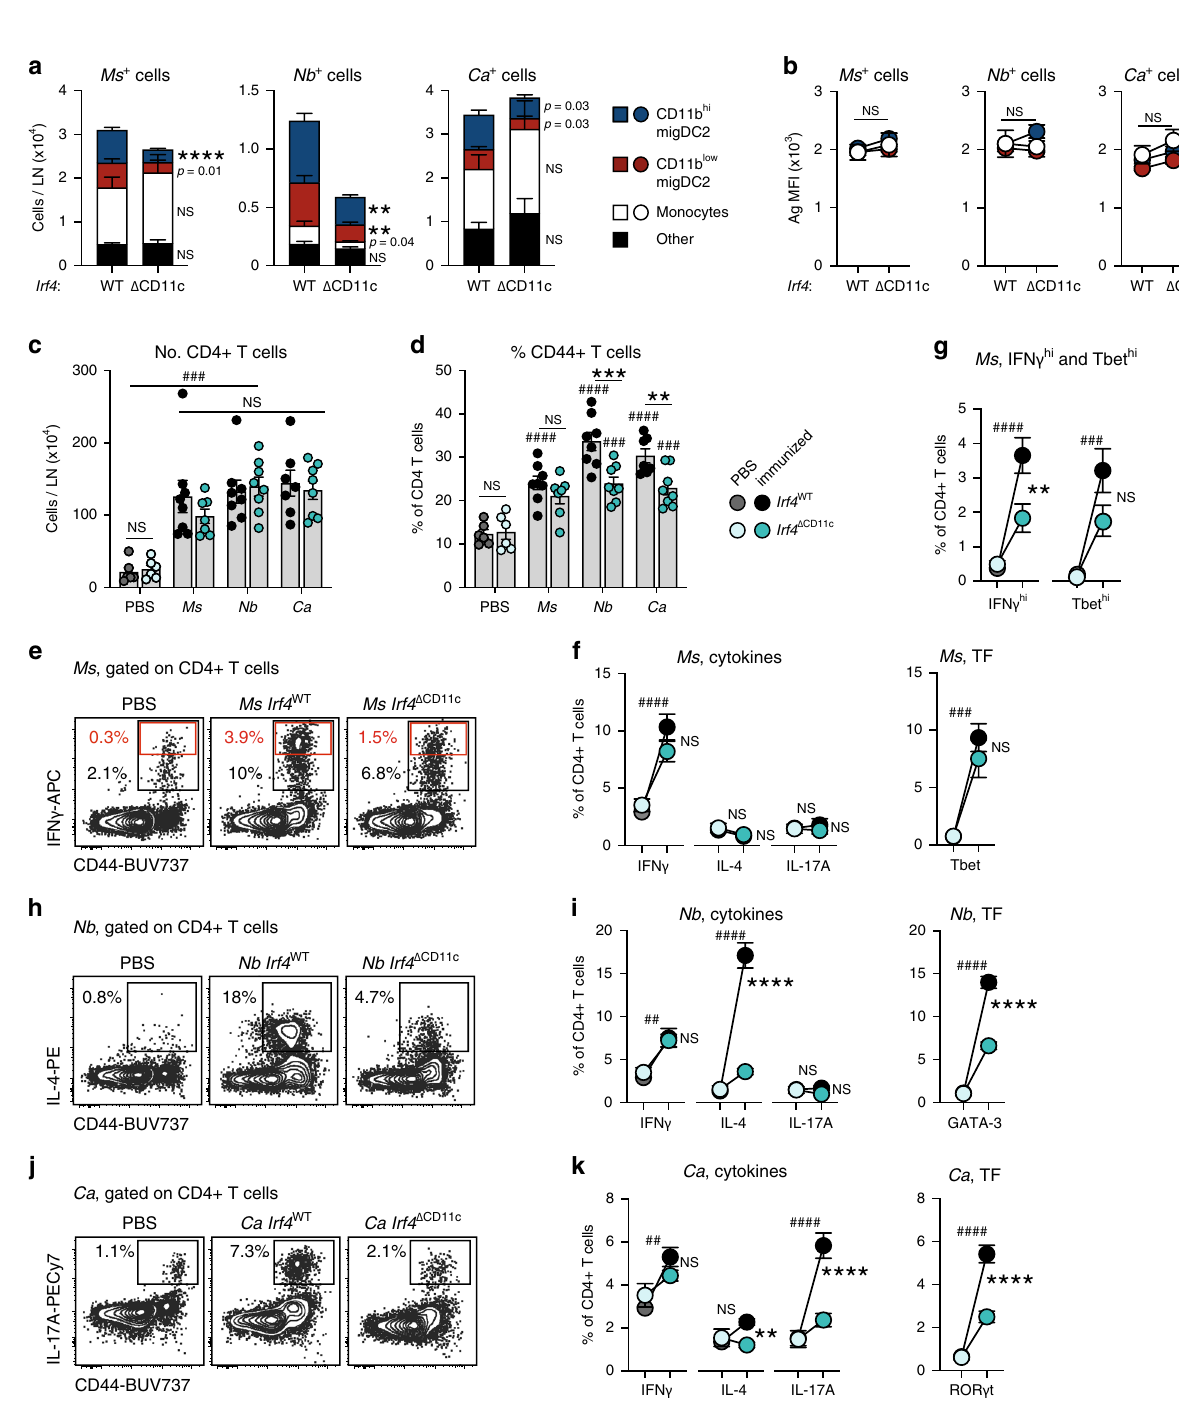
Fig. 2 Ag + DC express high levels of activation markers and transcripts associated with Th cell polarization. C57BL/6 mice were immunized i.d. with fl uorescently labeled Ms , Nb , Ca , or PBS as a control. Flow cytometry ( a – d ) and cell sorting ( e ) were performed on LN cell suspensions 2 days later. Bar graphs show mean median fl uorescence intensity (MFI) ± SD, each symbol corresponds to one mouse. a – d Expression of CD40, CD86, PDL2, and CCR7 across Ag + and Ag − DC subsets from PBS-injected or immunized mice. Group sizes are; n = 3 (CD40 PBS), 4 (CD86 immunized, PDL2 Ms and PDL2 Nb ) or 5 (CD40 immunized, CD86 PBS, PDL2 PBS, PDL2 Ca and all CCR7) female mice from 1 of 2 (CD40, PDL2, and CCR7) or 3 (CD86) independent experiments that gave similar results. Statistical signi fi cance was assessed using Two-Way ANOVA with Sidak ’ s post-test. Hash symbols above individual columns refer to comparisons to the PBS group. NS: not signi fi cant; ** ,## p < 0.01; *** ,### p < 0.001; **** ,#### p < 0.0001. Exact values are shown for 0.05 > p > 0.01. e Dynabead-enriched DC were sorted into Ag − and Ag + subsets for RT-qPCR analysis. Heatmaps show differential expression analysis (log2 fold change) of transcripts in DC subsets from immunized mice compared to PBS controls. Data refer to three biological replicates each containing cells sorted from pooled LN from fi ve female mice. Statistical signi fi cance was assessed using One-Way ANOVA with Holm – Sidak ’ s post-test; * p < 0.05, ** p <